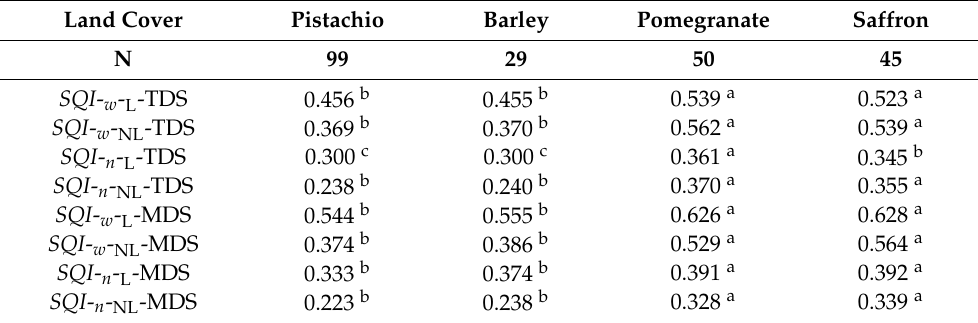
Table 4. Comparison of the mean values of soil quality indices through different cultivated lands. Land Cover Pistachio